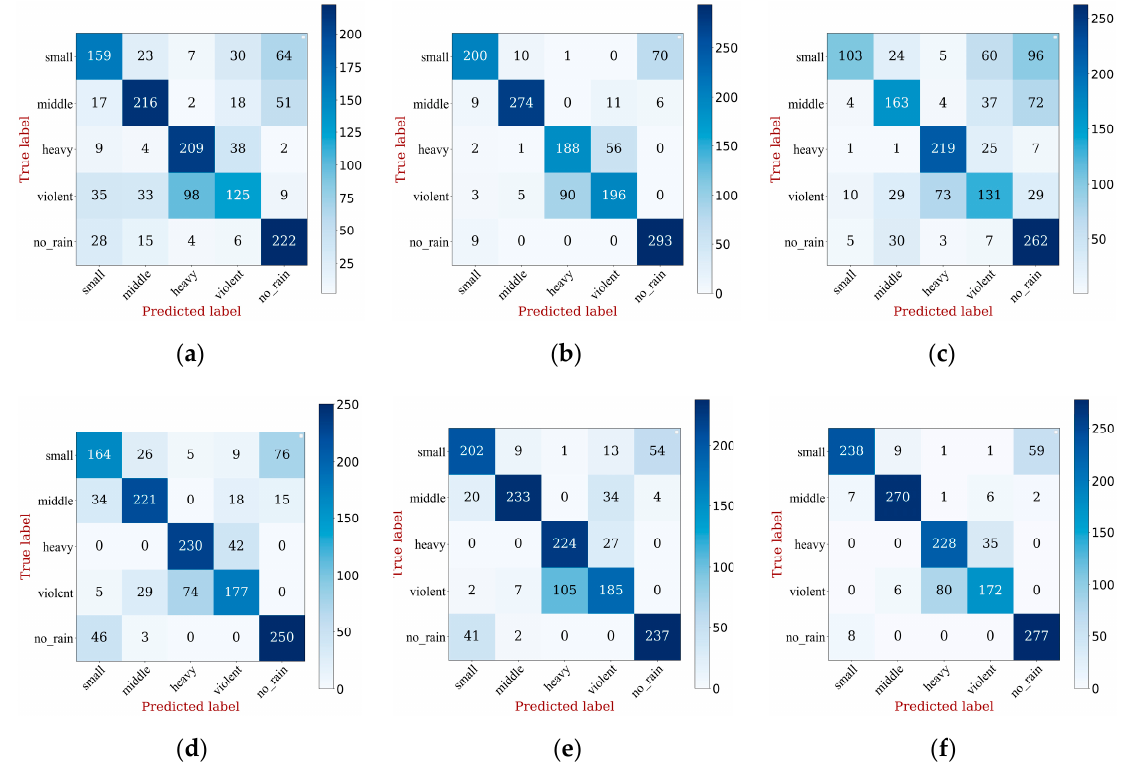
Figure 6. Confusion matrixes for different models. ( a ) CNN; ( b ) 5-stack CNN; ( c ) DS-CNN; ( d ) MRNet; ( e ) RACNN; ( f ) PNNAMMS.